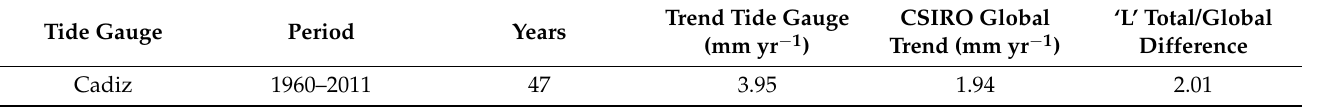
Table 3. Trend of mean sea level changes in the Cadiz tide gauge (a series of more than 30 years), with the adapted CSIRO series and the difference between them